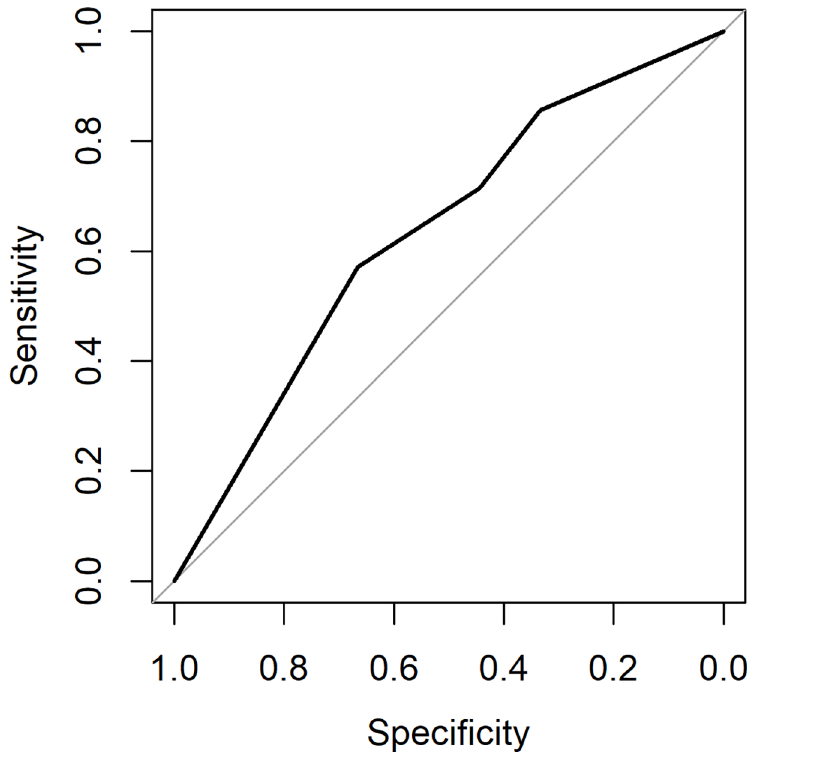
Fig 6. The AUC of the second lidocaine block was 0.63 (95% CI 0.36 to